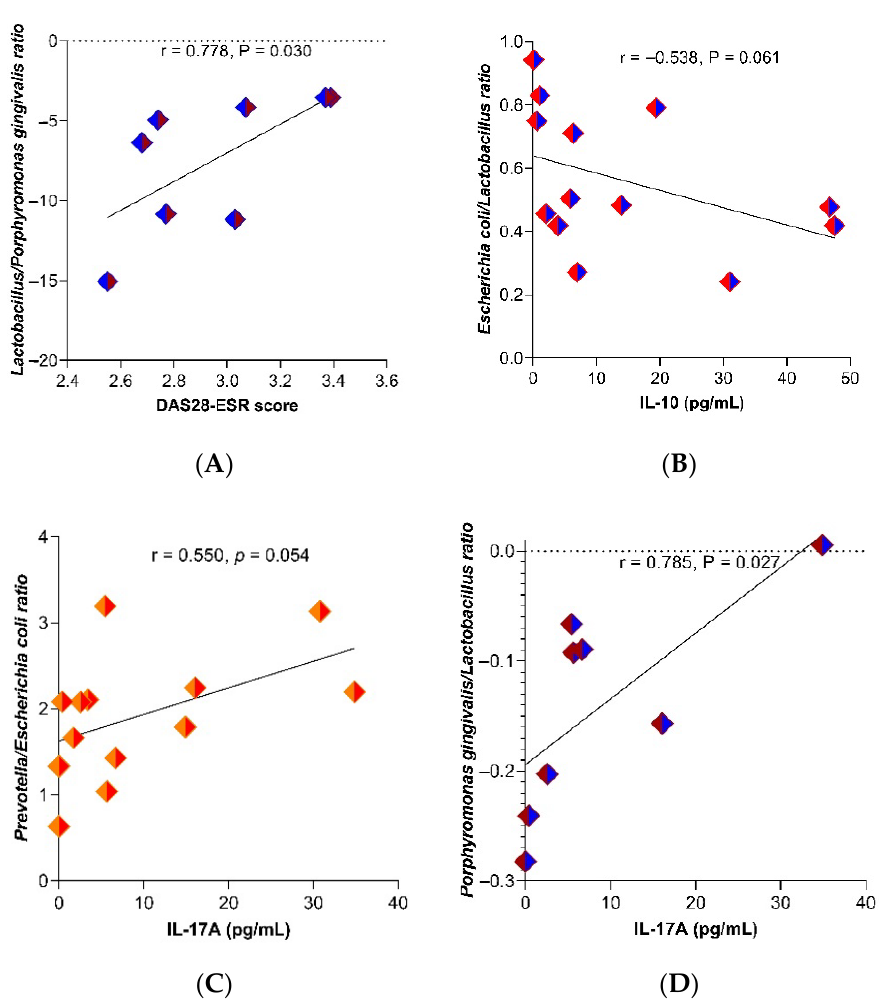
Figure 1. Correlation between clinical activity and cytokines on gut microbiota in RA patients with treated. ( A ) DAS28-ESR , ( B ) IL-10, ( C , D ) IL-17A. Spearman’s correlation. r = rho, correlation coefficient. p -Value < 0.05 was considered statistically significant.